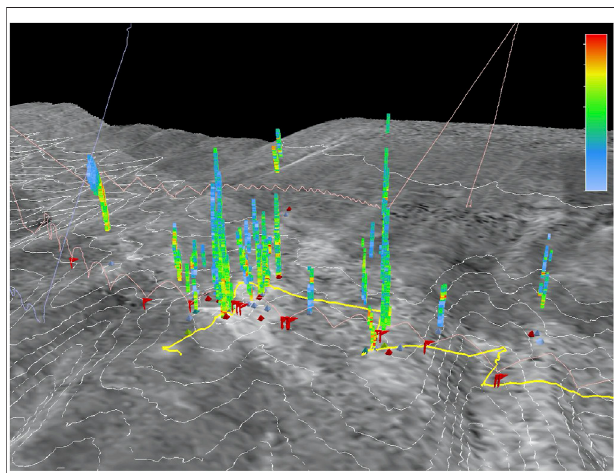
FIGURE 5 | AUG sonar observations of bubble plumes in SA1: Pacuare (red fl ags) compared with EM302 plume observations (pyramids represent sea fl oor source and blue-green-yellow-red colored stalks are bubble plumes with red colors indicating amplitudes of 3 – 10 dB and light blue amplitudes between − 30 and − 45 dB). Pink lines represent AUG fl ight path. Note that plumes identi fi ed at bottom of any fl ight cycle. Yellow line is ROV Dive 205/206 path. Closely spaced bathymetric contours in dive area at 10 m increments; shallowest depth contour at top of dive site is − 660 m, and shallowestdepthcontourattopofimageis − 600 m.VE (cid:2) 3x.ViewtoNE.Note that given AUG navigation uncertainties, reasonable correspondence found between EM302 and AUG plume